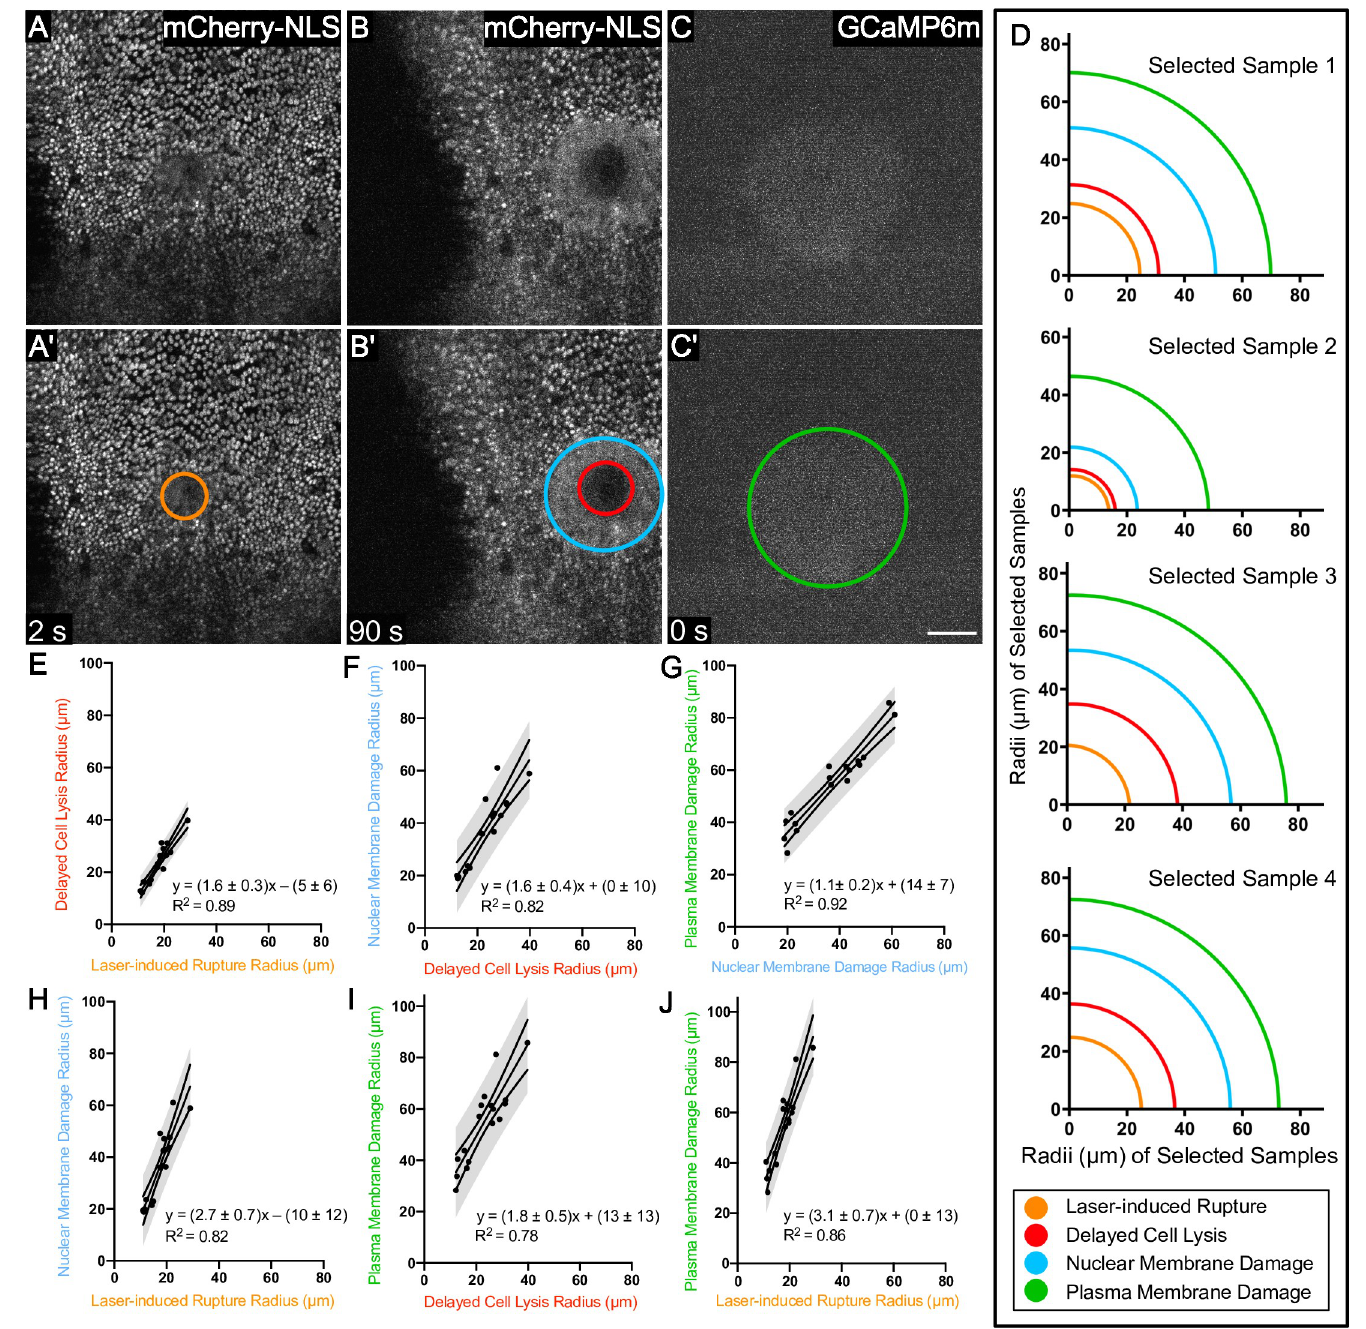
Fig 2. Several zones of damage are evident around pulsed-laser wounds. (A) The region of laser-induced rupture is observed as the area of disrupted mCherry.NLS within the first two frames after wounding (here 2 seconds), annotated with an orange circle in A’. (B) The region of delayed cell lysis is observed as the complete loss of mCherry.NLS at 90 seconds, (red circle in B’) and the region of nuclear membrane damage is observed as a diffuse, non-nuclear mCherry.NLS signal (light blue circle in B’), maintained within the cells by the plasma membrane at 90 seconds after wounding. (C) The region of plasma membrane damage is observed as an increase in cytoplasmic calcium levels immediately after wounding (green circle in C’, as reported by GCaMP6m, a fluorescent calcium indicator, in the first frame after wounding (here 0 seconds). In this region, the wound creates microtears in the plasma membrane, allowing immediate influx of extracellular calcium. All images are of the same wound; the frame is shifted in B,B’. (D) Actual measurements of radii in four different samples demonstrates a consistent relationship between these regions; as any one of these regions increases in radius, the others likewise increase in radius. Panels E-J quantify this trend with 95% prediction bands. n = 17 pupae. Scale bar = 50 μ m.